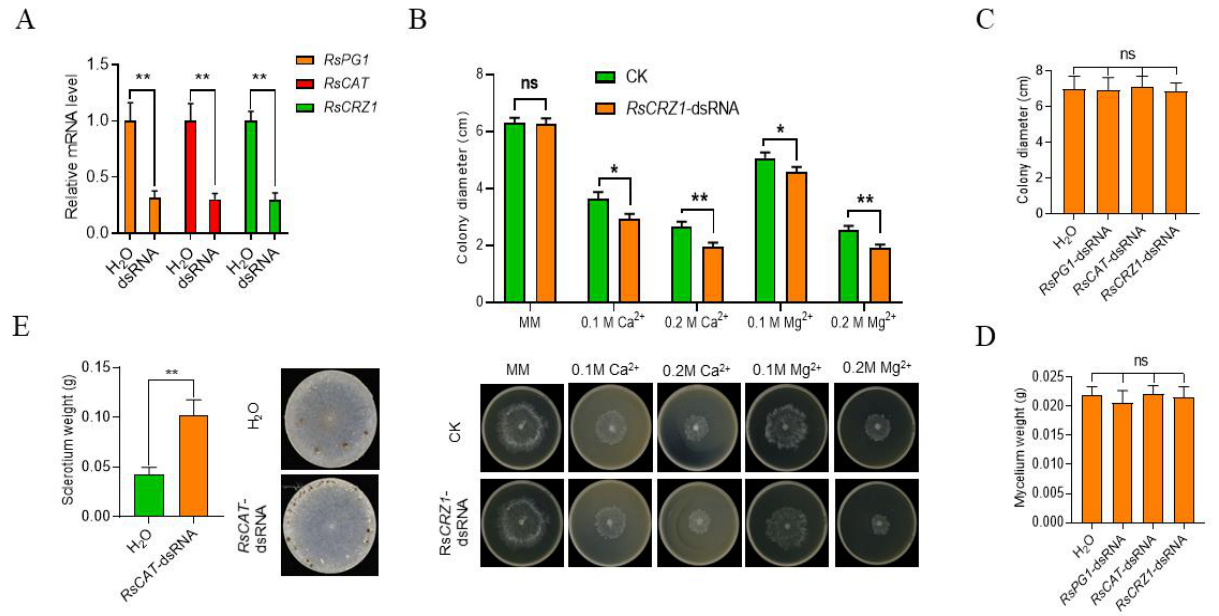
Figure 2. Effects of dsRNAs that target R. solani genes on R. solani growth and development. ( A ) Expression levels of RsPG1 , RsCAT, and RsCRZ1 30 h after spray with dsRNAs targeting these genes on R. solani growing on PDA medium. ( B ) Sensitivity of R. solani treated with RsCRZ1 -dsRNA to different concentrations of Ca 2+ and Mg 2+ . CK, control; MM, minimal medium. ( C ) Colony diameter of R. solani co-incubated with RsPG1 -dsRNA, RsCAT -dsRNA, or RsCRZ1 -dsRNA for 30 h. ( D ) Weight of mycelia collected from the cellophane sprayed with RsPG1 -dsRNA, RsCAT -dsRNA, or RsCRZ1 -dsRNA. ( E ) Sclerotia production and its weight after RsCAT -dsRNA treatment for 7 days on the pathogen in a petri dish. ns, no significant differences; *, p < 0.05; **, p < 0.01.